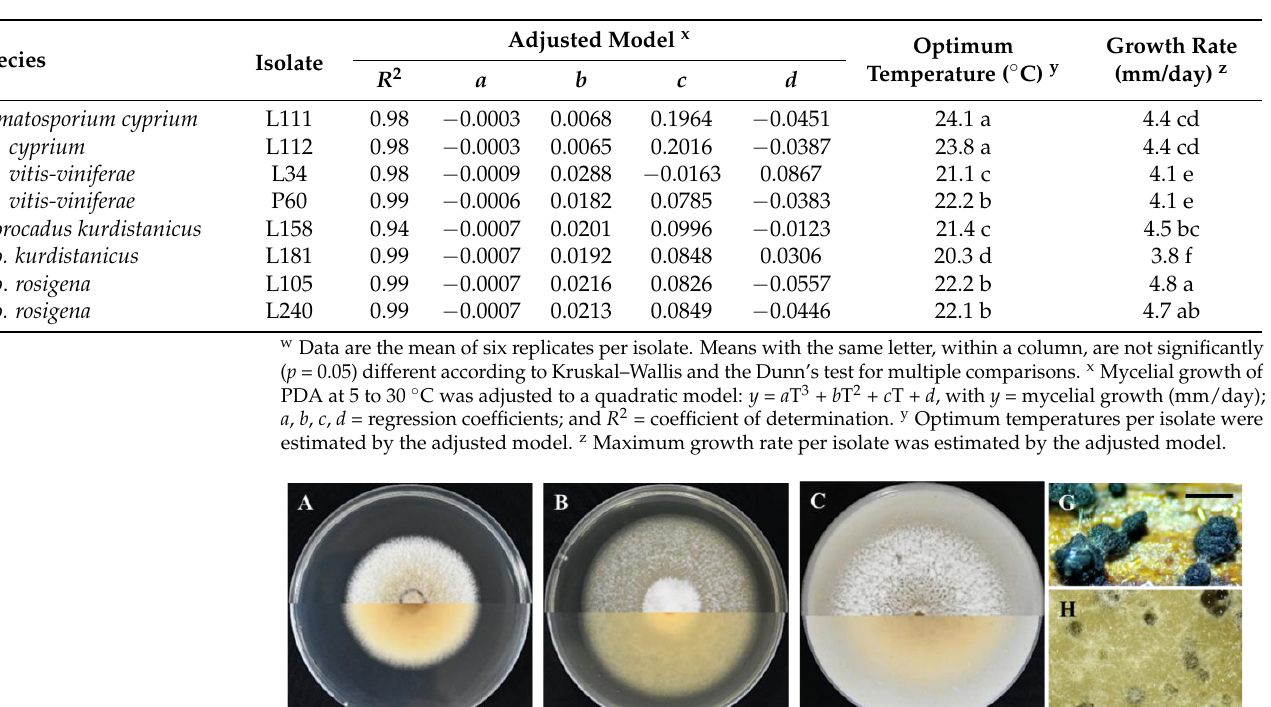
Table 1. Temperature-mycelial growth relationship for Sporocadaceae isolates from indigenous grapevine cultivars w .